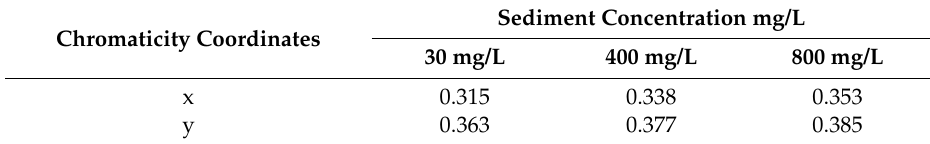
Table 4. Verification of chromatic coordinates of 15 cm water depth with changes in sediment